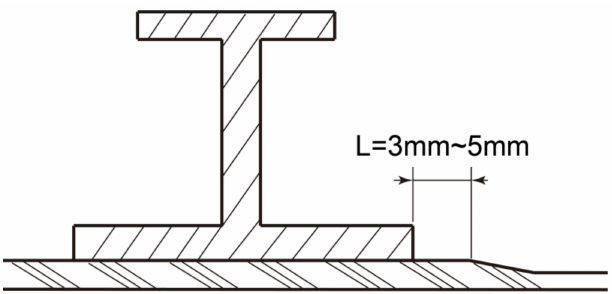
Figure 17. Reserved compensating distance between the transition region and the